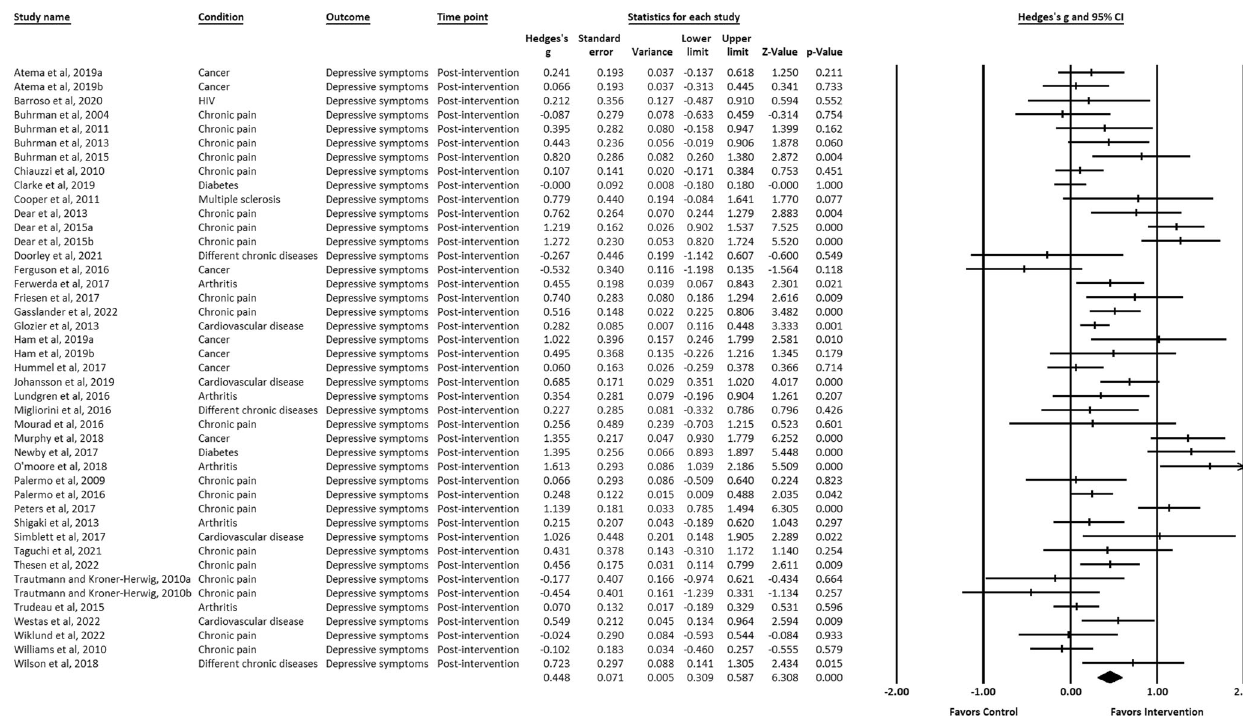
Fig. 2 Forest plot for effect sizes of IM-CBT on depressive symptoms at post-intervention.